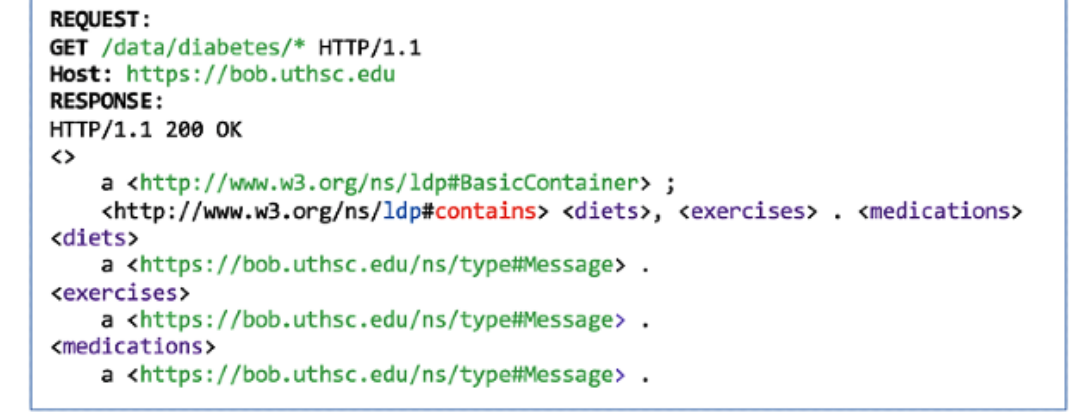
Figure 11. A GET request on Bob’s diabetes messages folder under his